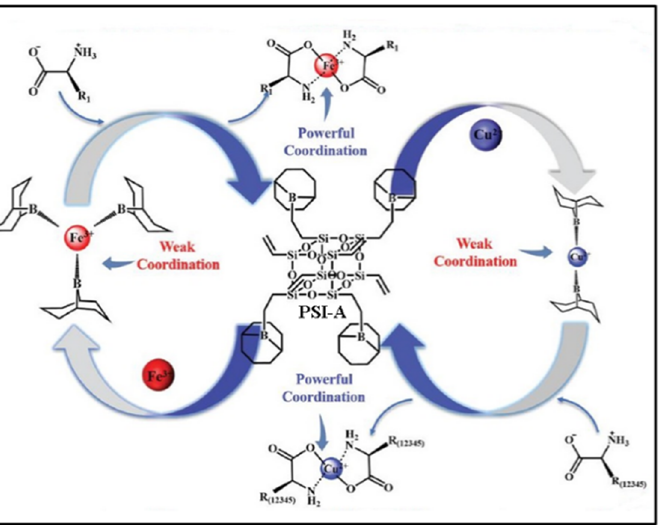
Figure 13. Schematic illustration of sensing mechanism of PSI-A towards Cu 2+ , Fe 3+ , and amino acids [91].